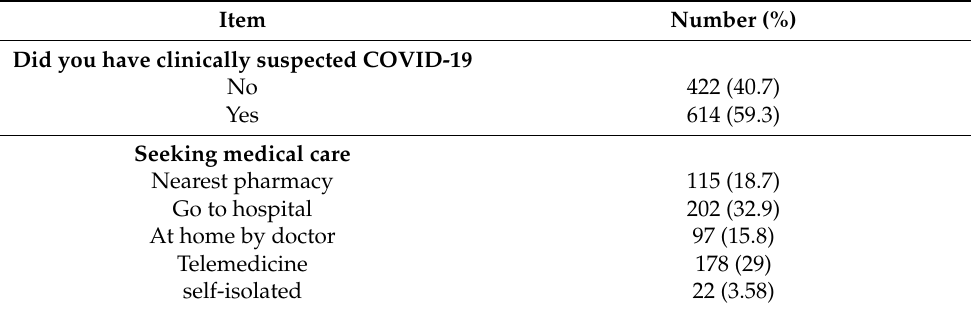
Table 2. COVID-19 infection status and medical treatment received.